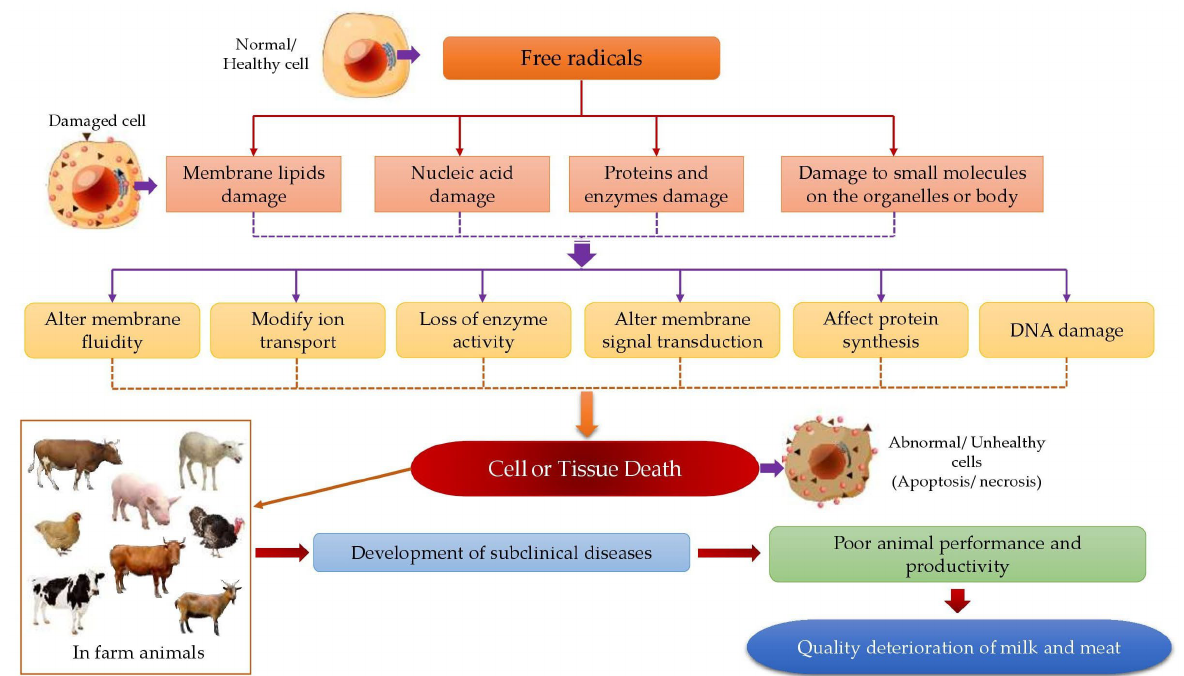
Figure 3. Impact of free radicals on the animal cells and tissues. Free radicals attack membrane lipids, proteins, nucleic acid, and small molecules on the cell and alter the key properties and functions of cells (membrane fluidity, ion transport, enzyme activity, membrane signal transduction, protein synthesis, and DNA damage). At extreme levels, cause cell or tissues necrosis, which result in the development of subclinical diseases, leading to poor animal performance, productivity, and consequently quality deterioration of milk and meat from farm animals.